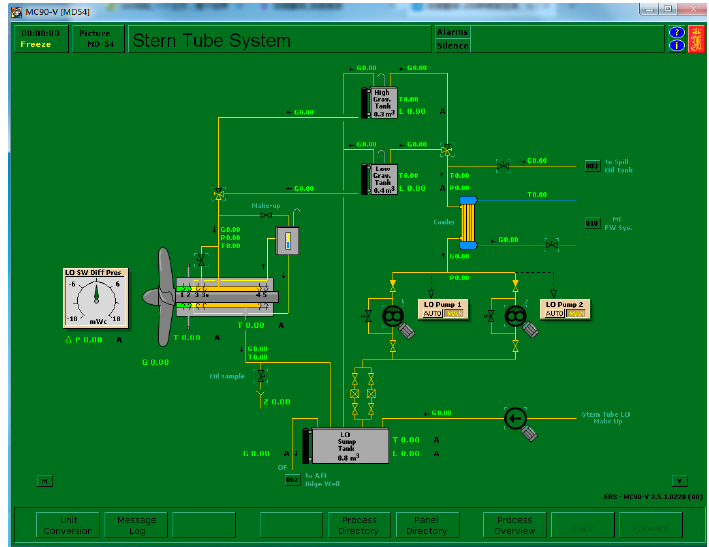
Figure 1. Operation interface of stern tube system.